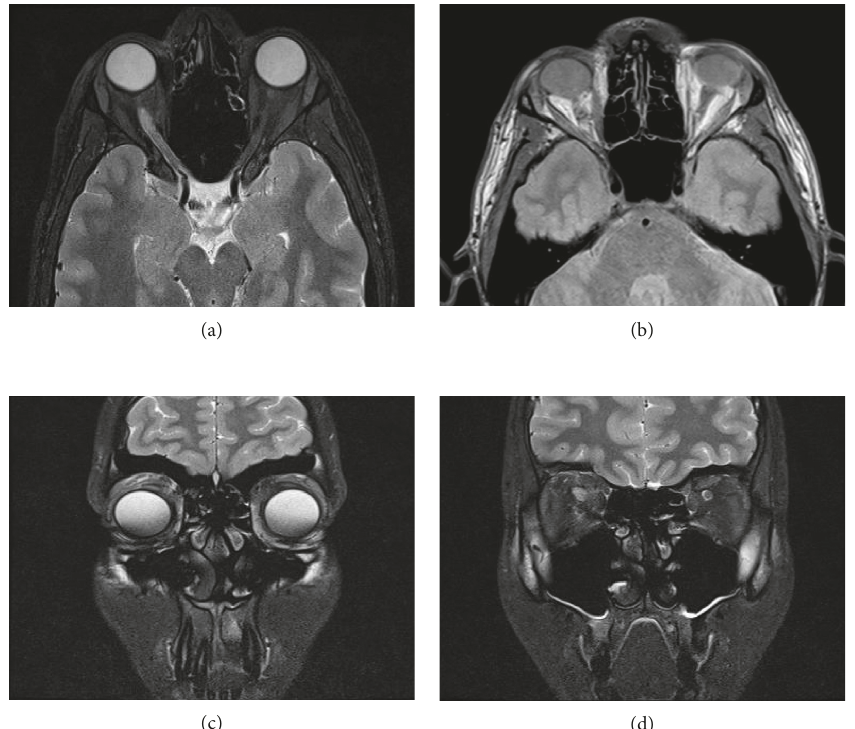
Figure 8: Postoperative MRI scans (3 months). Axial and coronal T1 (a, c) and T2-weighted (b, d) MRI images show normal anatomical conditions with no residual tumor